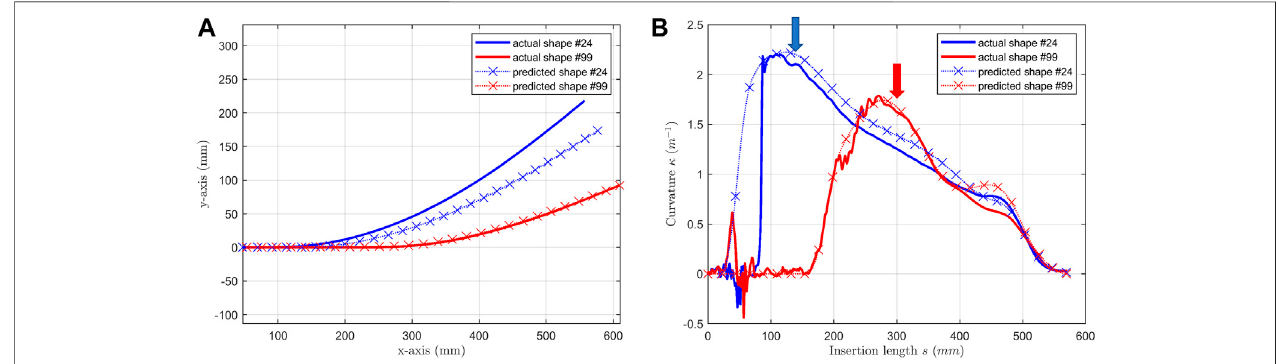
FIGURE 9 | Selected shapes (shape #24 & #99) predicted by the NN model with unidirectional LSTM. (A) predicted shapes are compared with actual shapes; (B) predicted curvatures are compared with actual curvatures.